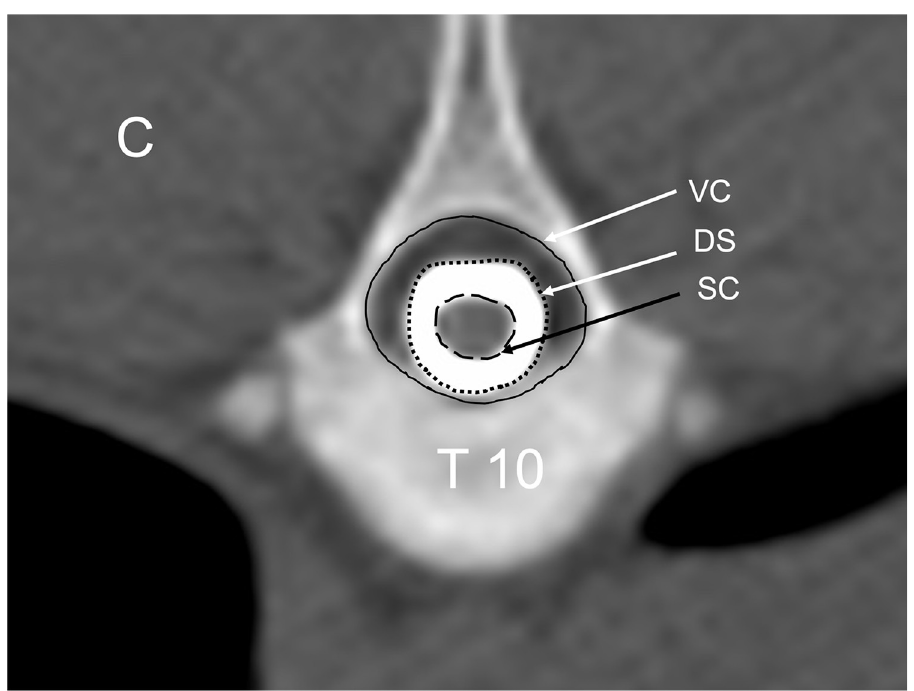
Fig 4. Transverse CT myelogram image showing manual delineation for area measurements. Spinal cord (SC), dural space (DS), and vertebral canal (VC). This site has the qualitative designation of C for continuous contrast filling of the subarachnoid space. C = continuous and concentric filling of the subarachnoid space.